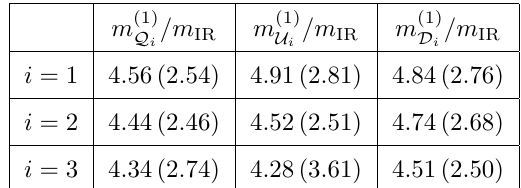
Table 1 . Masses of the (cid:12)rst fermionic KK modes in model II using the (cid:26) -values that correspond to the benchmark point from ref. [41] and, in brackets, for the case of constant bulk masses. are (75{80)% heavier than the latter (except for the left-handed top-bottom doublet and the right-handed top for which the mass increase is smaller). This can be